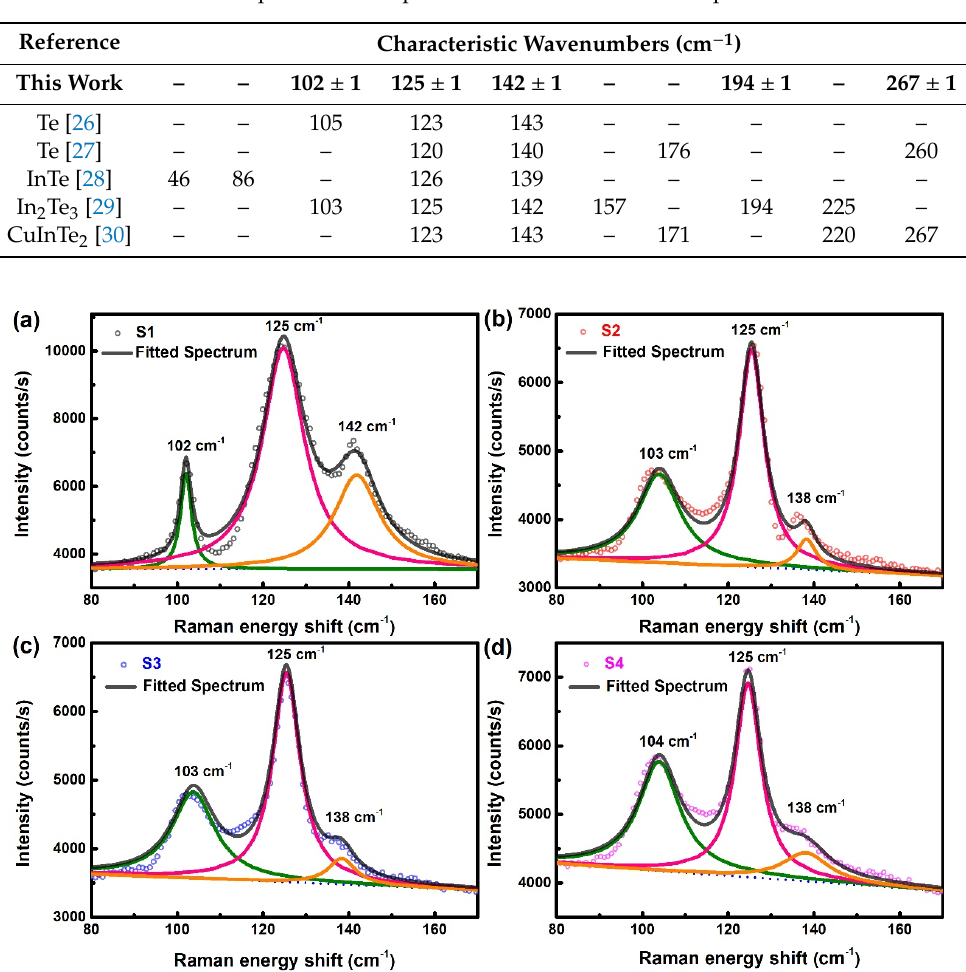
Figure 3. The peak fitting Raman spectra of Ta-doped InTe thin films: ( a ) S1, ( b ) S2, ( c ) S3, ( d ) S4